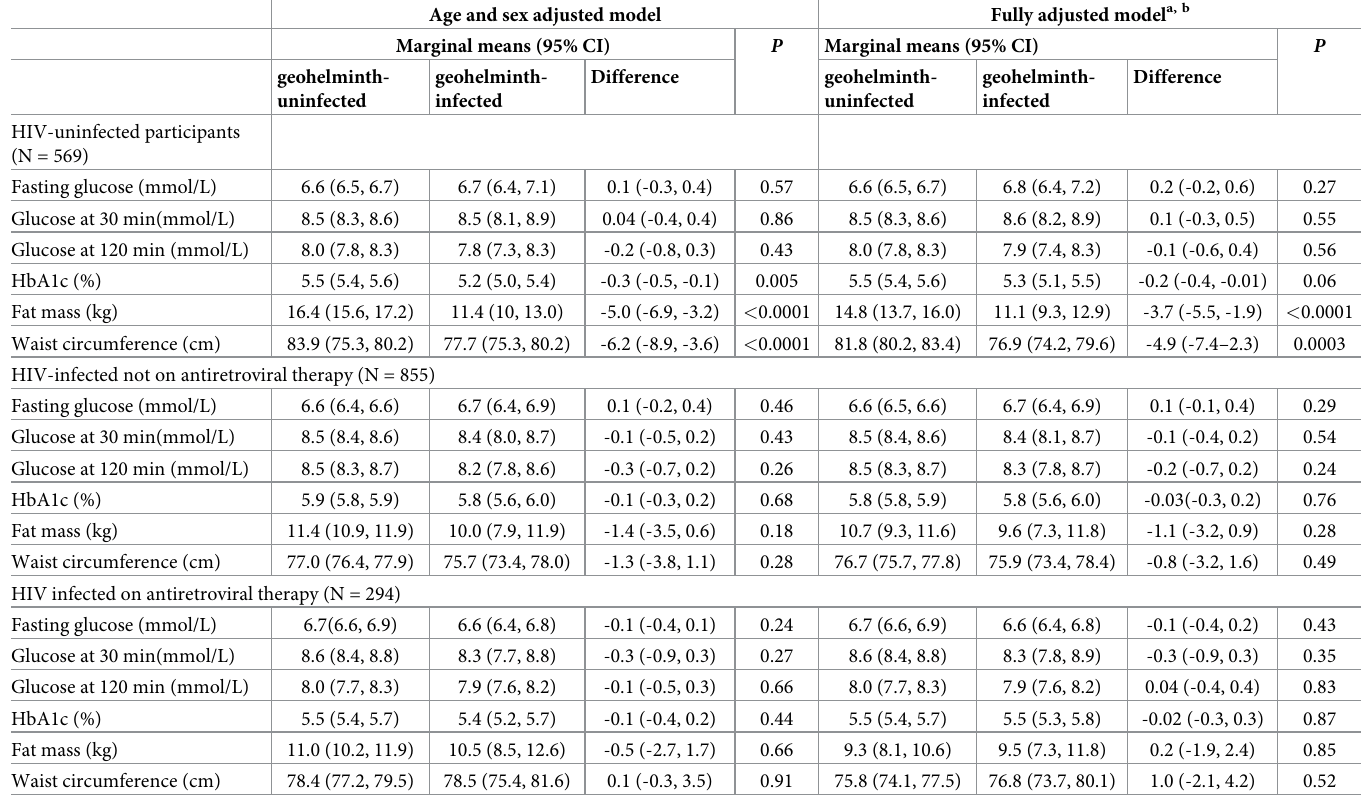
Table 5. Analysis of association of geohelminth infection with glucose, HbA1c, fat mass, and waist circumference by HIV treatment